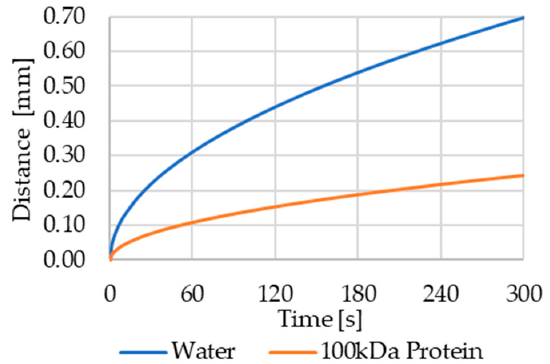
Figure 8. Average diffusion distance of water and a 100 kDa protein in aqueous solution. In 60 s, water molecules cover an average distance of 0.3 mm, while the protein will only cover 0.1 mm.